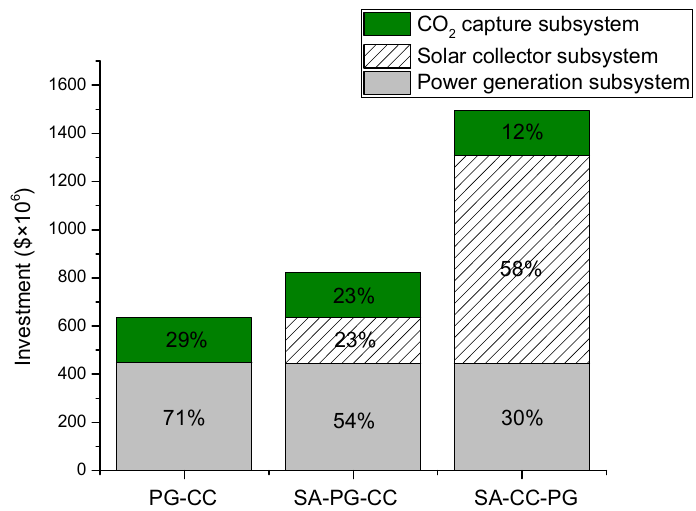
Figure 12. Investment in coal-fired power-generation system with MEA-based CO 2 capture (PG-CC), solar-aided coal-fired power generation with CO 2 capture (SA-PG-CC) and solar-aided CO 2 capture coal-fired power generation (SA-CC-PG).